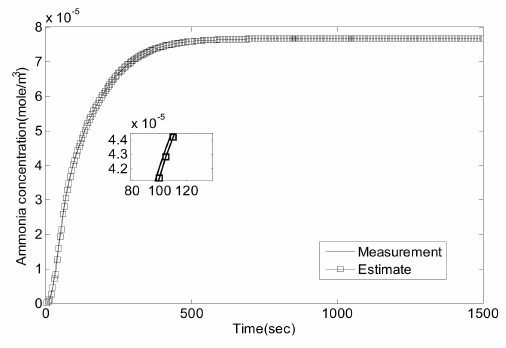
Figure 9. NO 2 / NO = 1 / 2, 350 ◦ C, comparison of C NH